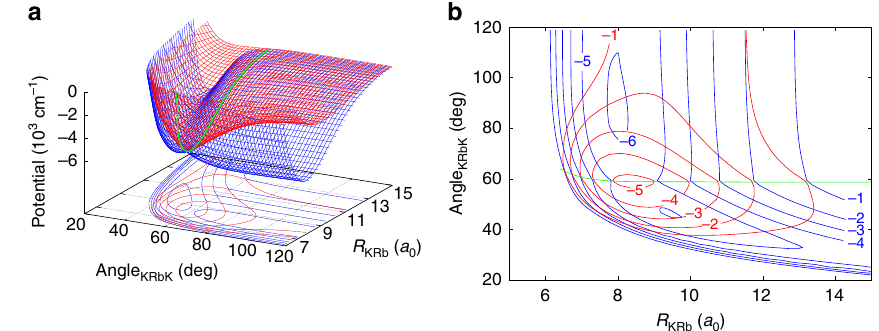
Figure 1 | K–KRb potential energy surface. ( a ) A two-dimensional cut through the energetically lowest 2 A 0 (blue curve) and 2 B 0 (red curve) adiabatic potential energy surfaces of the KRbK trimer as a function of the K (cid:2) Rb bond lengths and the angle between K (cid:2) Rb (cid:2) K along the isosceles C 2 n geometry with R K1Rb ¼ R K2Rb . The base of the figure shows the corresponding contour graph. The zero of energy corresponds to the energy of three well-separated atoms. The unit of length is the Bohr radius a 0 ¼ 0.0529177nm and that of energy is wavenumbers. ( b ) A contour graph of the K (cid:2) Rb (cid:2) K potentials based on the data in a . Contour labels are in units of 10 3 cm (cid:2) 1 . In both panels the seam of conical intersections is shown by the green